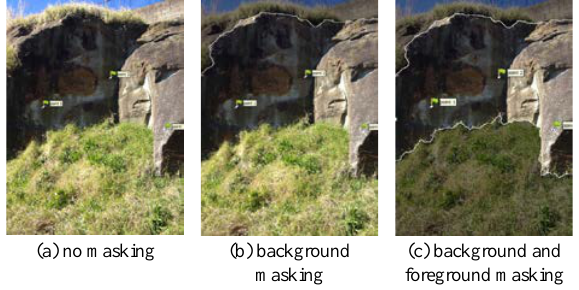
Figure 5. The different masking scenarios used for a preliminary error analysis after alignment